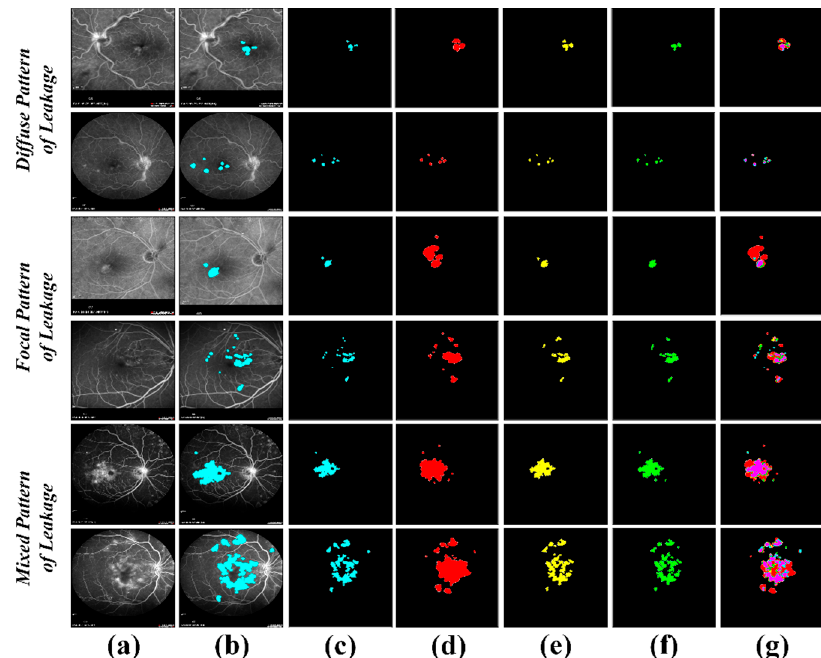
Figure 10. Segmented hard exudates region in the [37] dataset. ( a ) Original FA scans; ( b ) overlaid hard exudates region on original FA scans; ( c ) extracted hard exudates region through the proposed system; ( d ) Grader 1 markings of hard exudates region; ( e ) Grader 2 markings of hard exudates region; ( f ) Grader 3 markings of hard exudates region; ( g ) hard exudates extraction against expert markings—red, yellow and green represents the expert markings of Grader 1, 2 and 3, respectively, cyan represents the hard exudates region extracted through the proposed system and magenta represents the overlapped region of hard exudates.